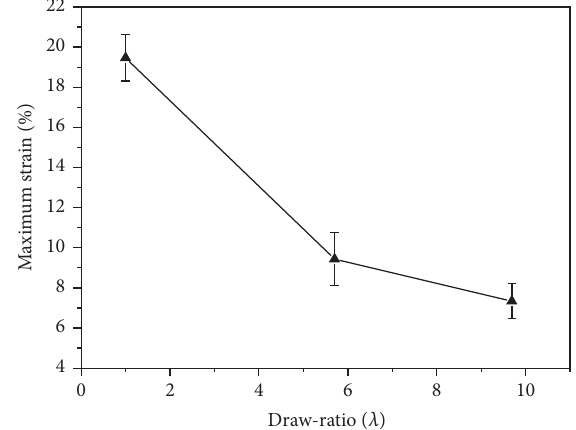
Figure 6: Strain to failure of as-spun PET bristle ( 𝜆 = 1 ), solid-state drawn PET after the first draw ( 𝜆 = 5.7 ), and second draw ( 𝜆 = 9.7 ),